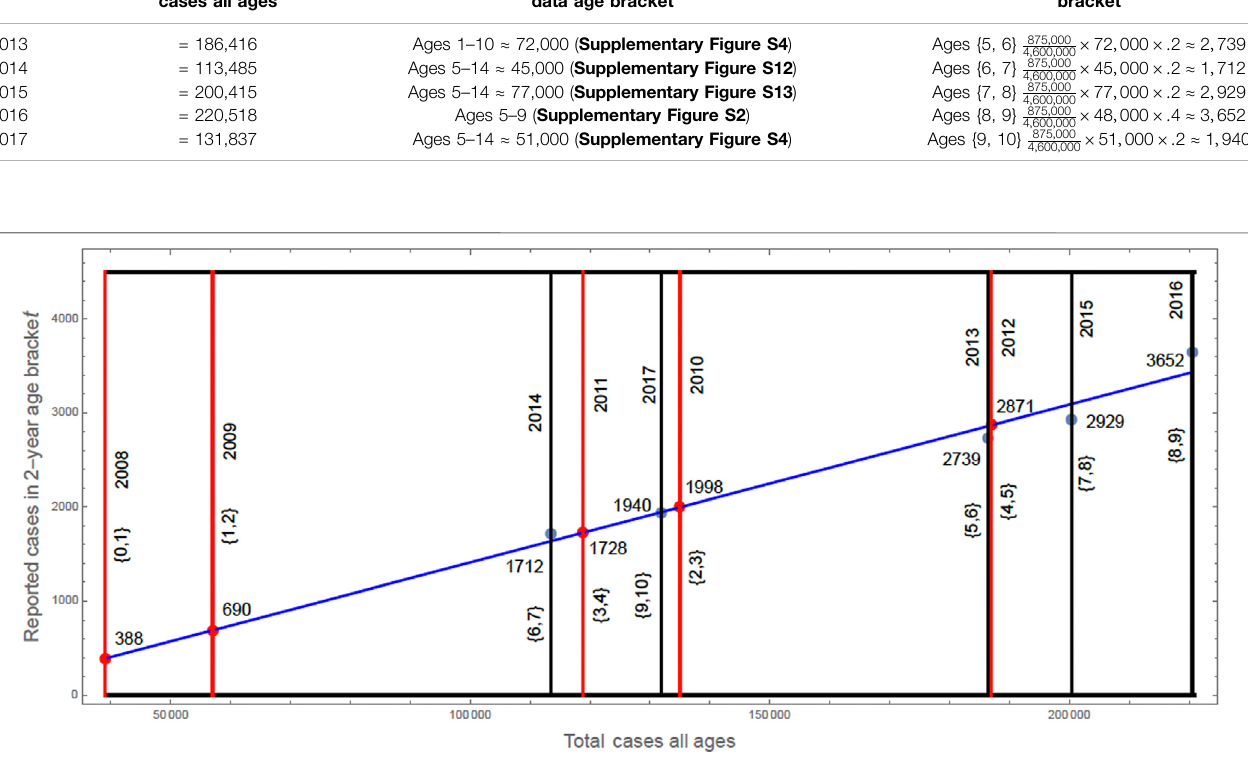
Frontiers in Applied Mathematics and Statistics |